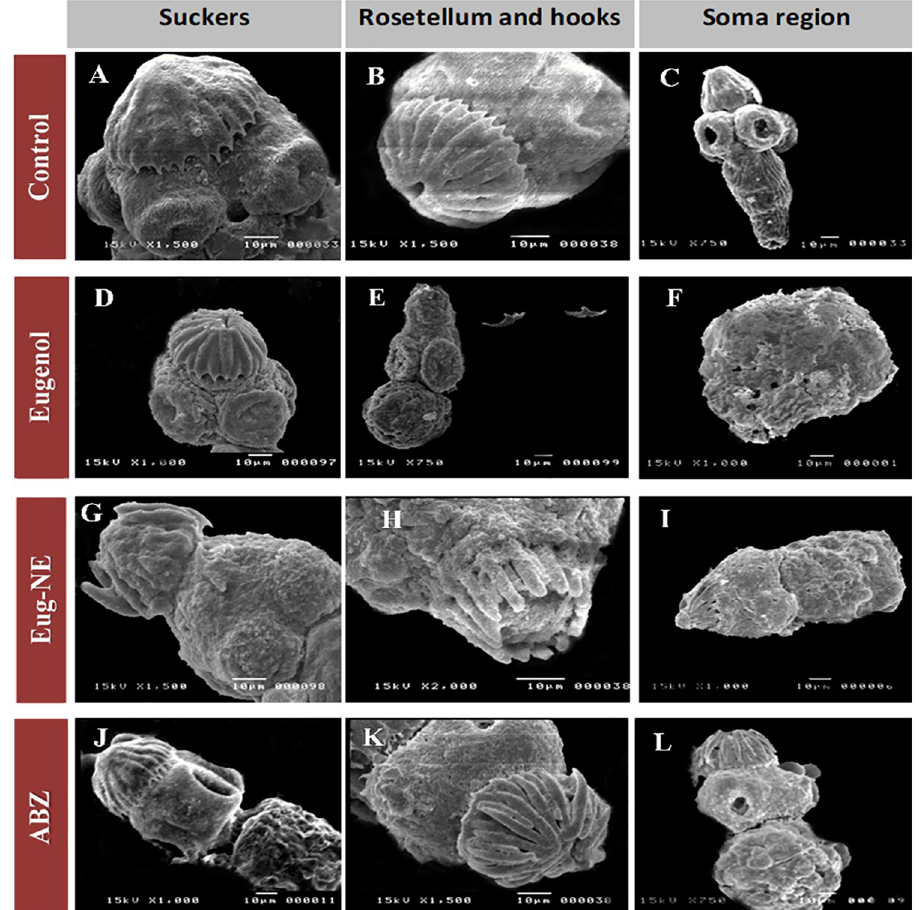
Eug. A complete loss of rostellar hooks and disruption of suckers can be observed. Contraction of the soma region with the shedding of microtriches and loss of tegumental integrity in the form of holes. (E) × 750 and ( D and F ) × 1000. (G– I) PCs treated with 0.2 μ l/ml Eug-NE. The tegument is markedly damaged with loss of microtriches. Disruption of suckers and disorganization of hooks with partial or complete loss of them can be observed. (G) × 1500, (H) × 2000, and (I) × 1000). (J–L) Treated PCs with 800 μ g/ml ABZ showed disorganization of rosetellar hooks and minimal disruption of suckers with tegumental changes as blebs could be observed. (J) × 1000, (K) × 1500, and (L) ×